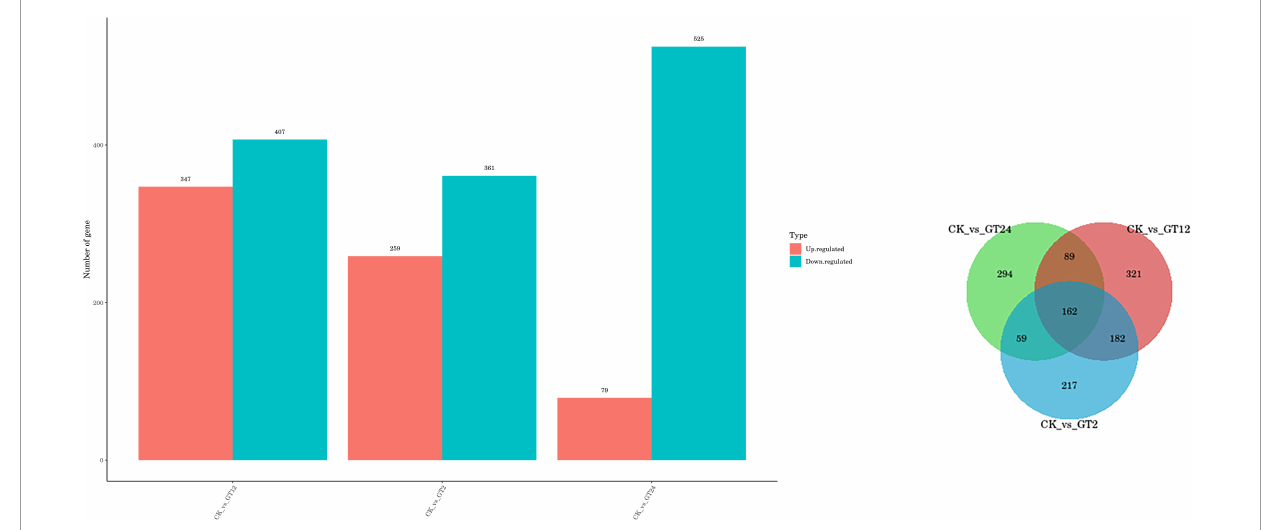
FIGURE1 Differentially expressed genes (DEGs) between samples. Left : numbers of DEGs compared between two samples (CK vs. GT2, CK vs. GT12, and CK vs. GT24). DEGs are shown in red (up-regulated) and blue (down-regulated). Right : Venn diagram analysis of the DEGs in Ganoderma lingzhi after inoculation with Trichoderma hengshanicum .